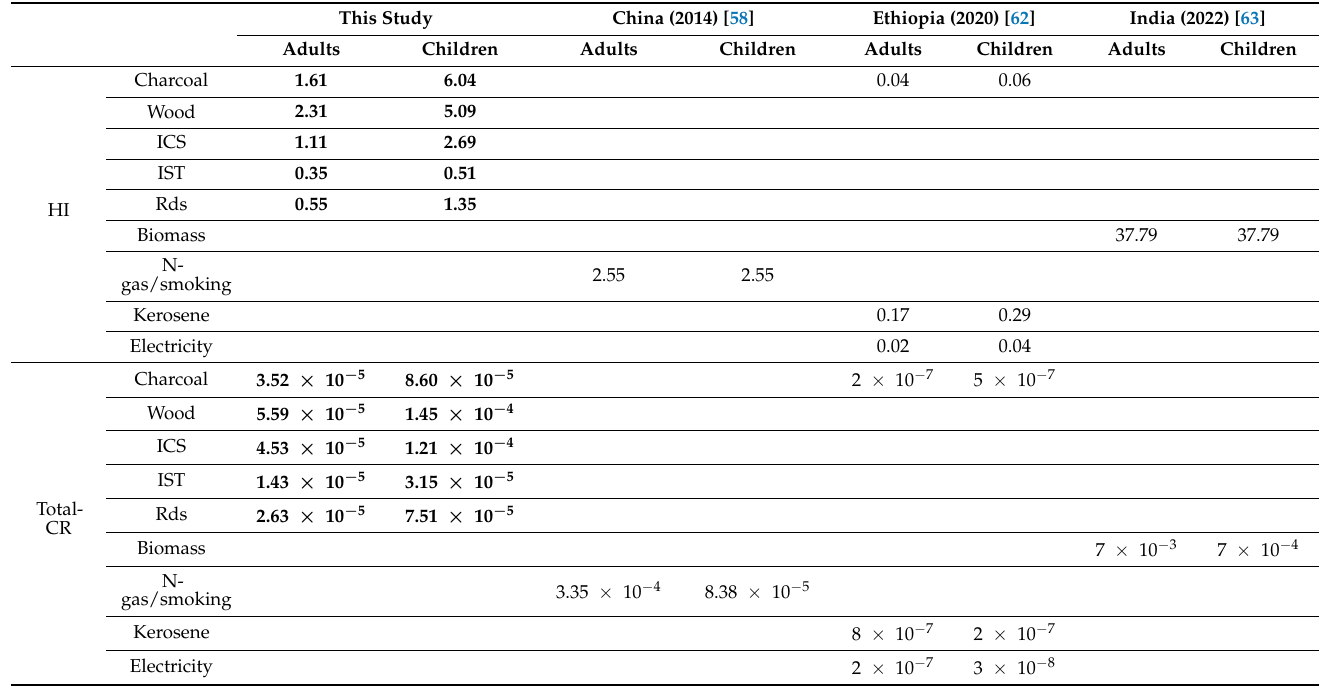
Table 4. Non-carcinogenic and carcinogenic risks of toxic metals in adults and children from